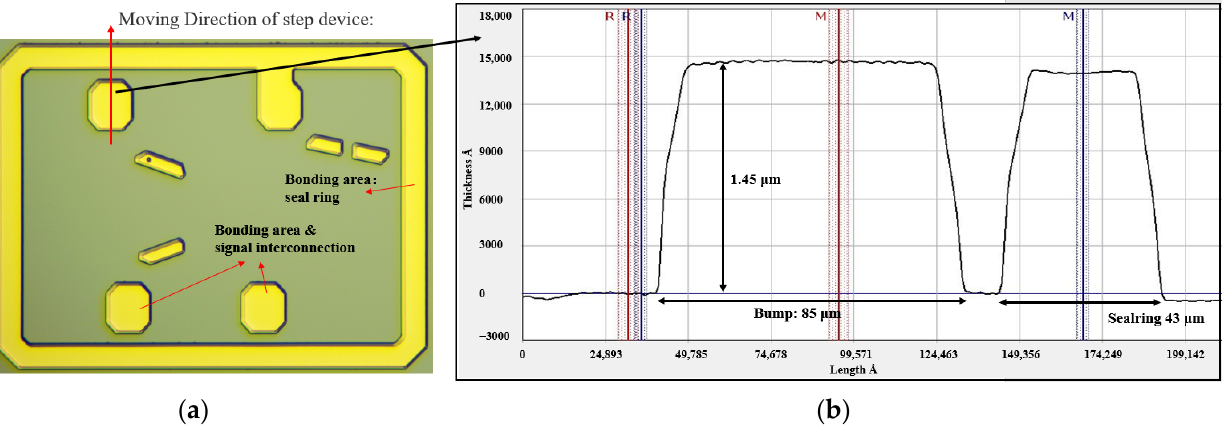
Figure 6. The structure of dummy device wafer; ( a ) The pattern of dummy device wafer; ( b ) The thickness and opening of Au bonding layer.